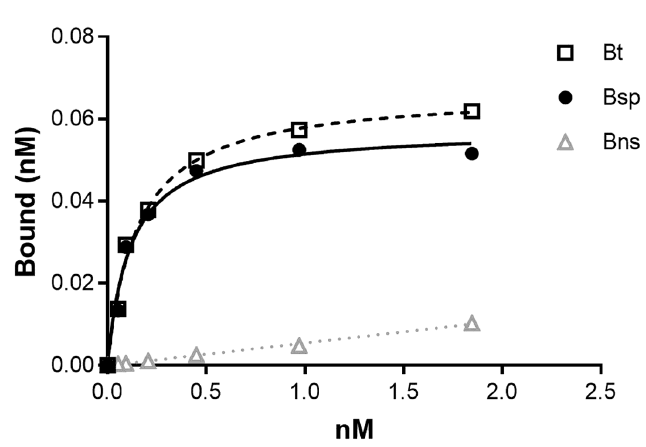
Figure 5. Representative plot from an in vitro 6-[ 18 F]FPy-T140 saturation binding assay using HeLa cells with each point representing the average of duplicates. B t = Btotal; Bns = Bnon-specific (determined in the presence of 10 −6 M unlabeled T-140 peptide); Bsp = Bspecific (Bt-Bns).